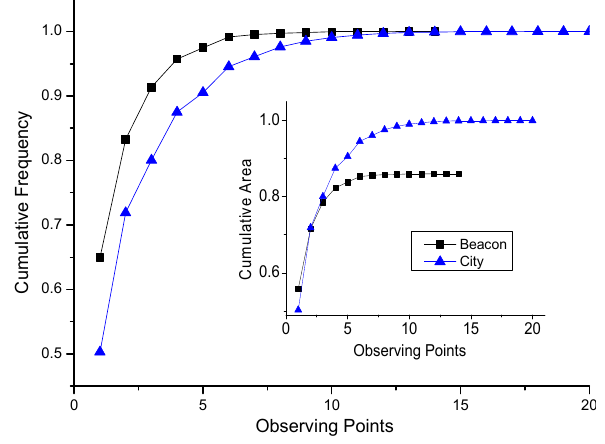
Figure 9. Cumulative viewshed of city sites and beacon tower.